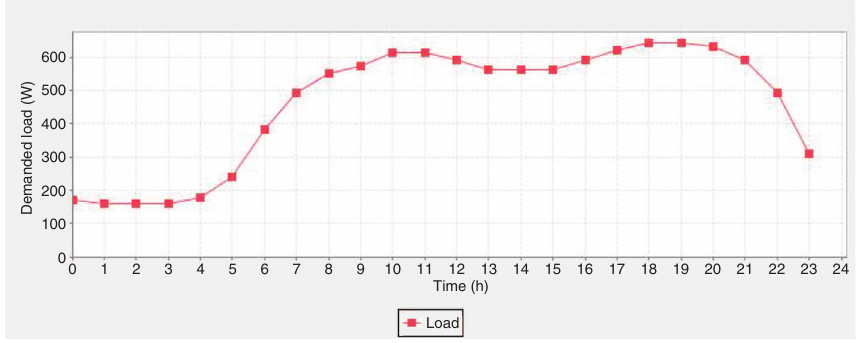
Figure 9: Profile of the Load Power of the Adopted MG.